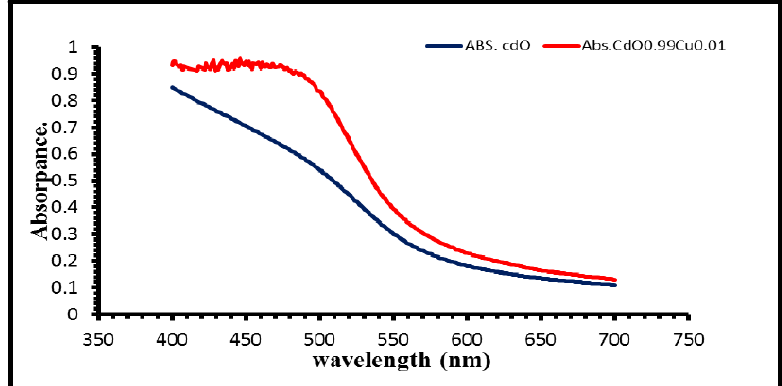
Fig.4: Absorpance spectrum of CdO and CdO